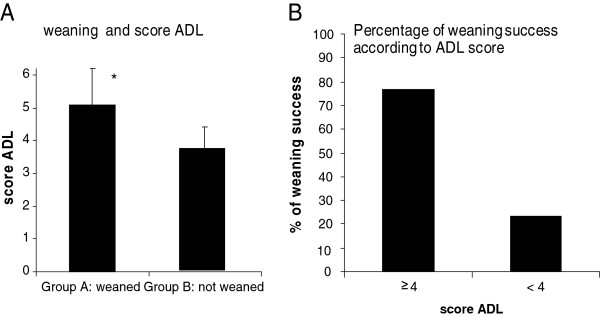
A. Weaning and ADL score. B. Percentage of weaning success according to ADL score.